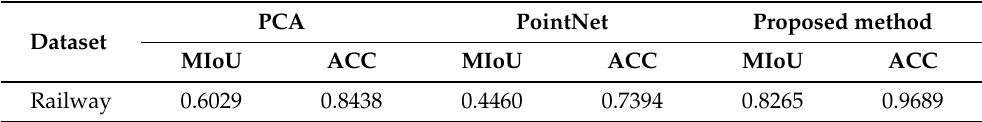
Table 6. Comparison of the MIoU and ACC of the three different wire segmentation